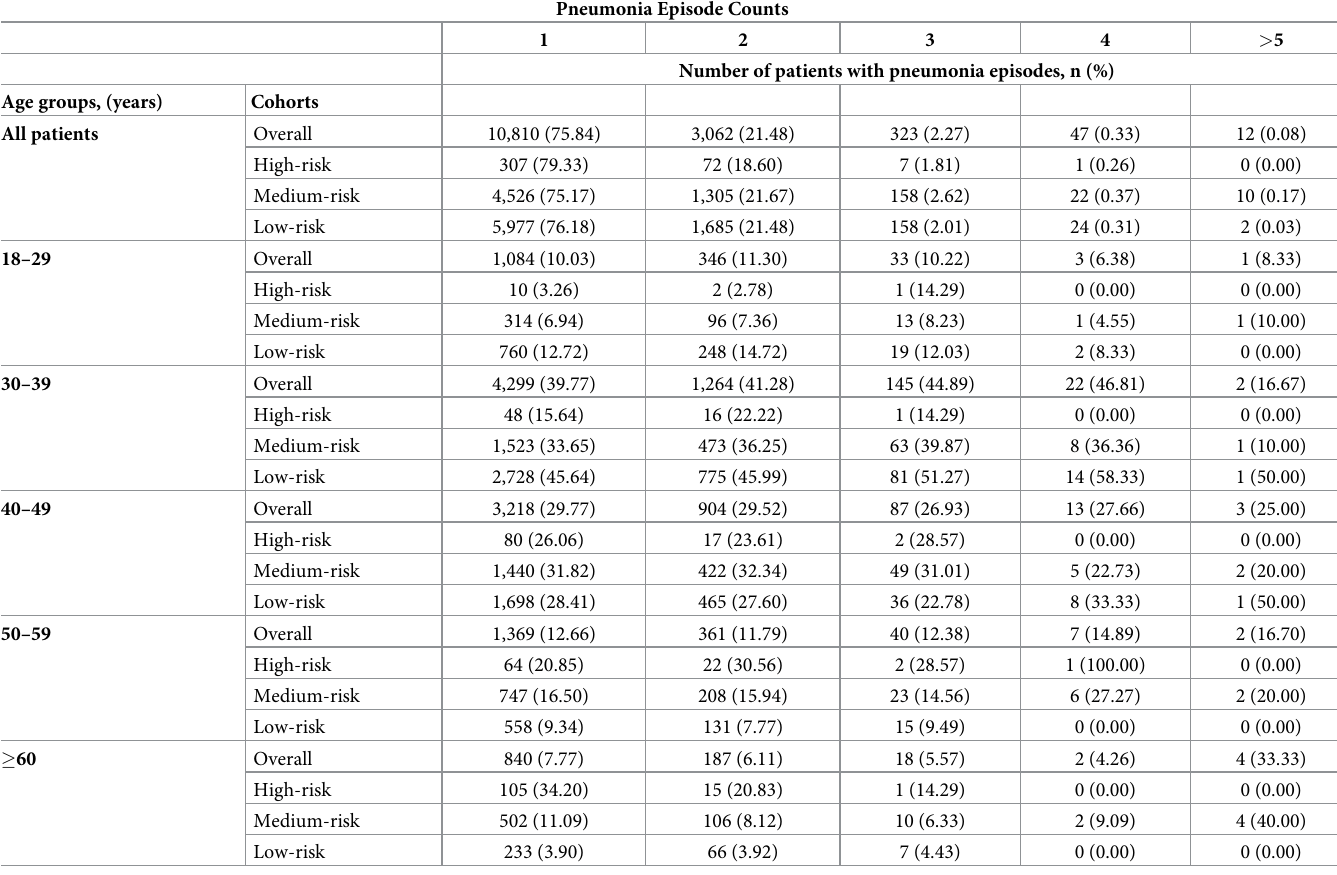
Table 2. Pneumonia episodes in age-stratified populations (patients having at least one claim for pneumonia during 12-month follow-up period were included in the analysis; Dubai Real-World Claims Database, 2014 to